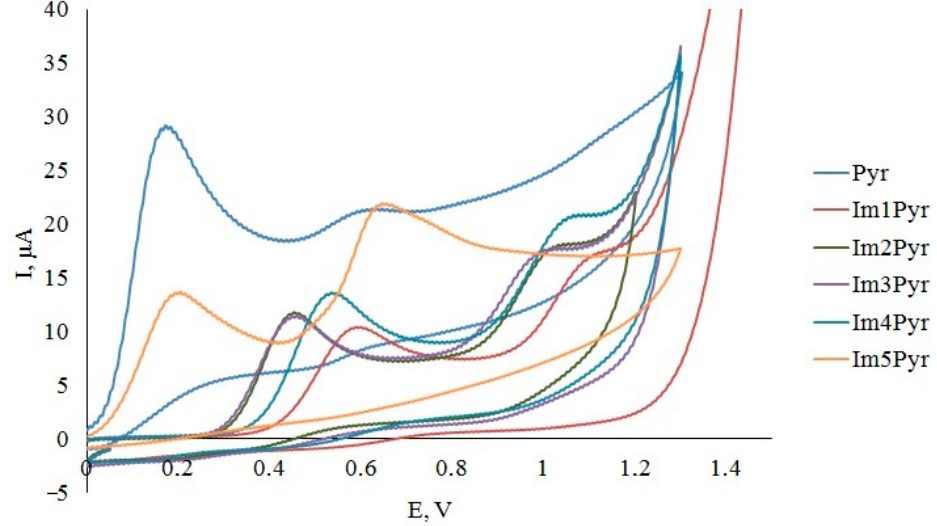
Figure 5. Cyclic voltammograms of pyrogallol and imidazolylpyrogallols recorded on the glassy carbon electrode (C = 1 mmol/dm 3 ; background: 0.1 mol/dm 3 KCl; scan rate 0.1